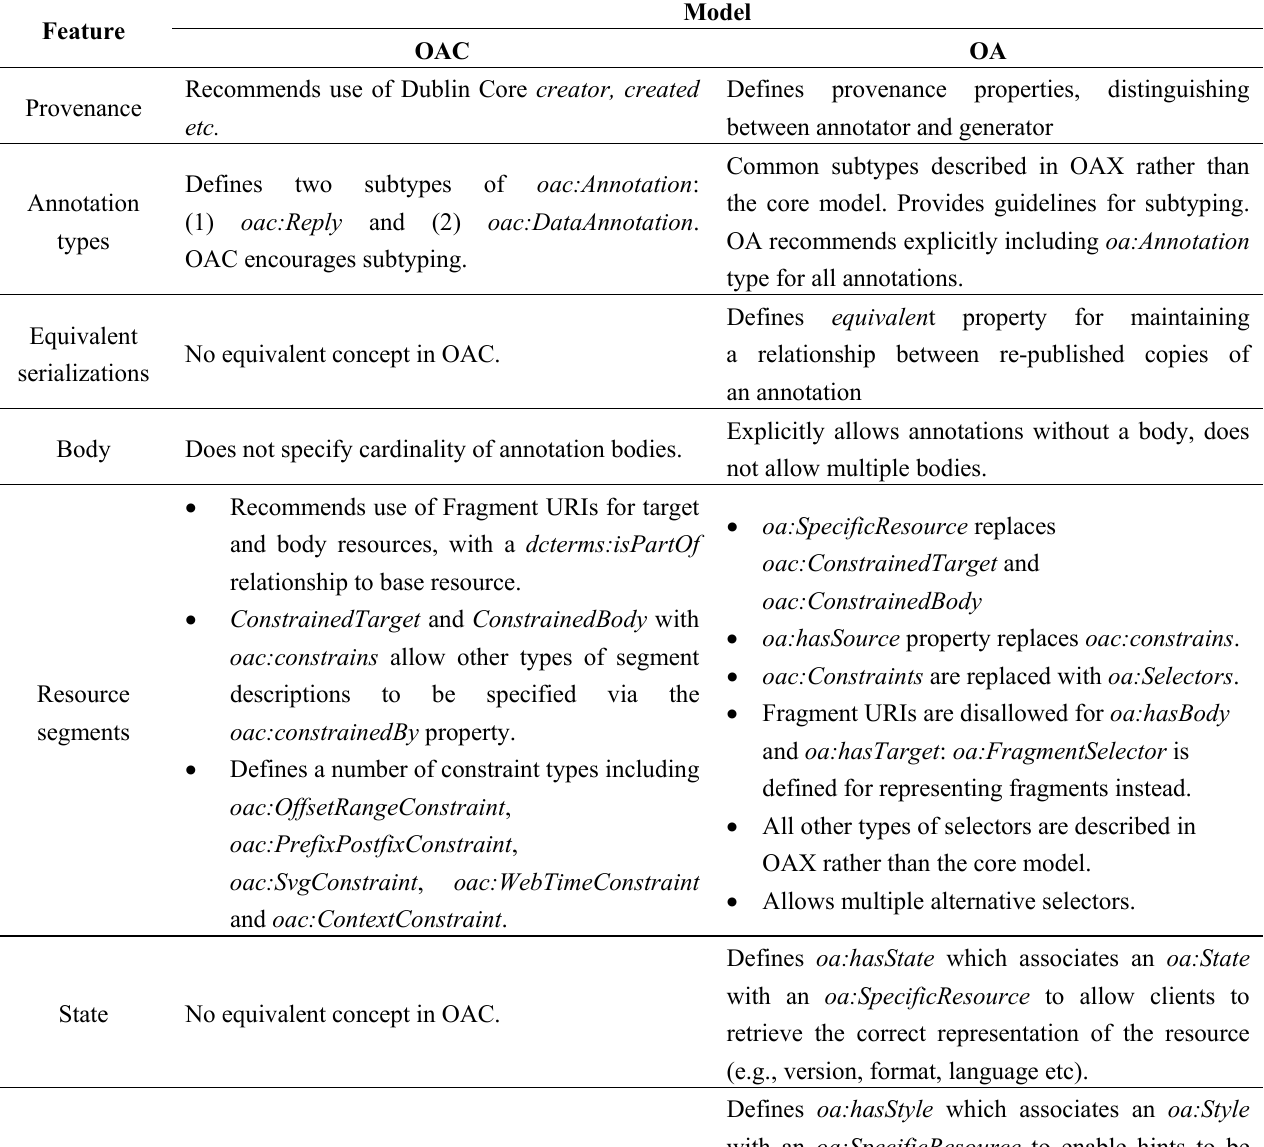
Table 1. Comparison of Open Annotation Collaboration (OAC) and OA